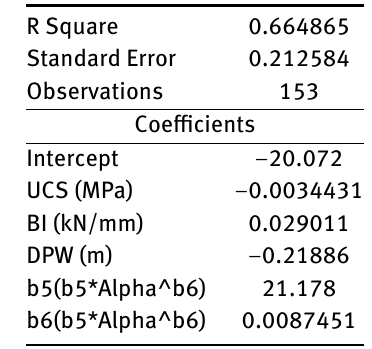
Table 5: Nonlinear regression model with exponential Alpha.